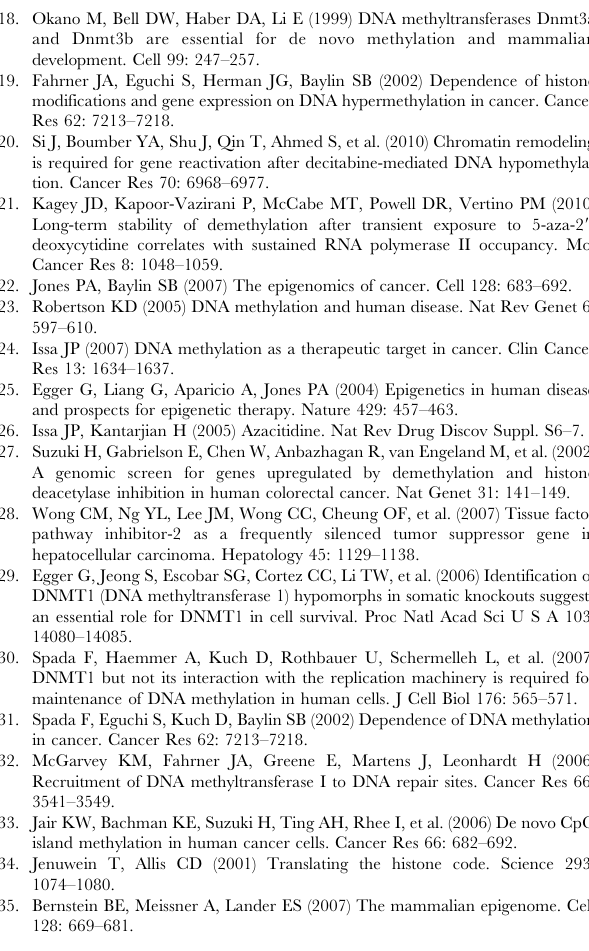
house keeping gene, GAPDH were served as controls. Figure S4 Enrichment of H3K4-me3 in DLC1 promoter upon 5-Aza-dC treatment. SMMC-7721 was treated with 10 uM 5-Aza-dC for 96 hrs. ChIP assay was performed with specific antibody against H3K4-tri-methylation (Upstate). Relative enrichment of H3K4-me3 in 5-Aza-dC treated cells was determined by Q-PCR. Table S1 PCR primers and TaqMan